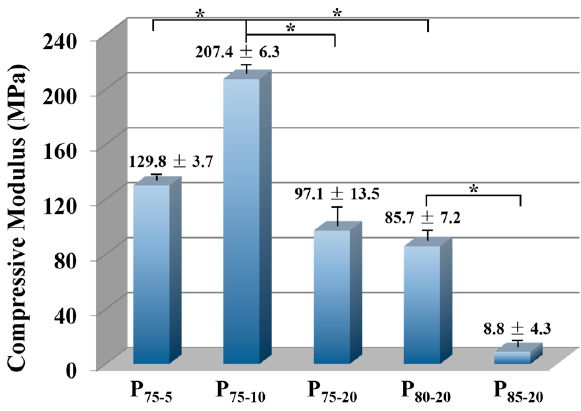
Figure 6. Compressive modulus of scaffolds for different compositions. * indicates p < 0.05.